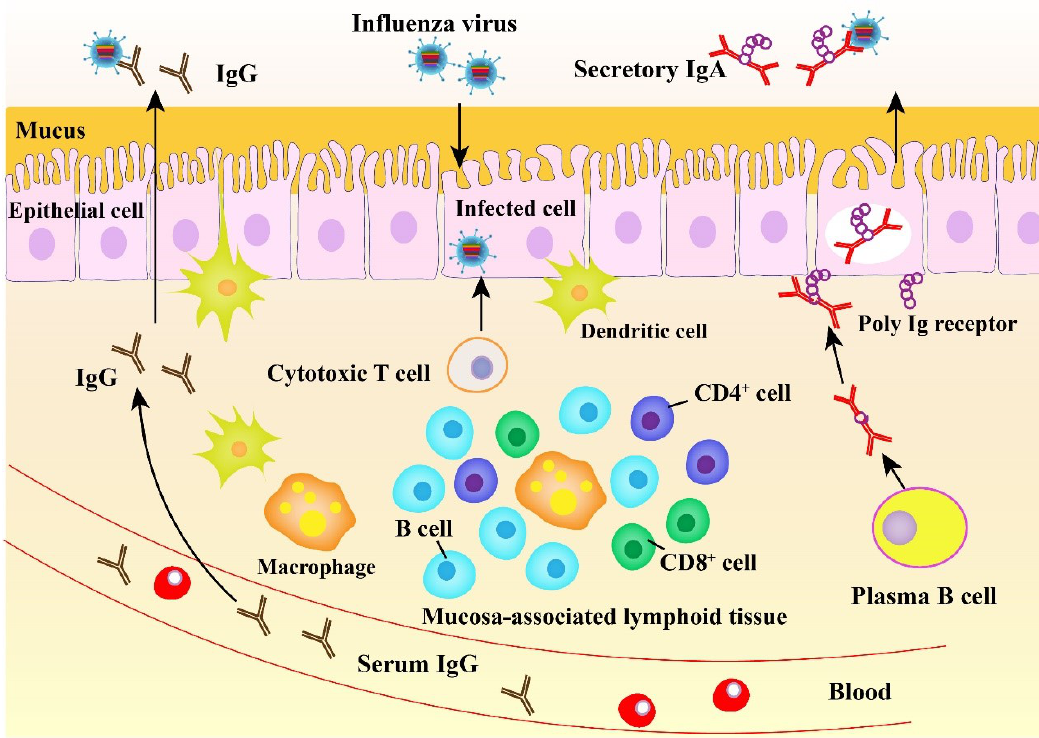
Figure 2. The mucosal immunity against influenza virus.